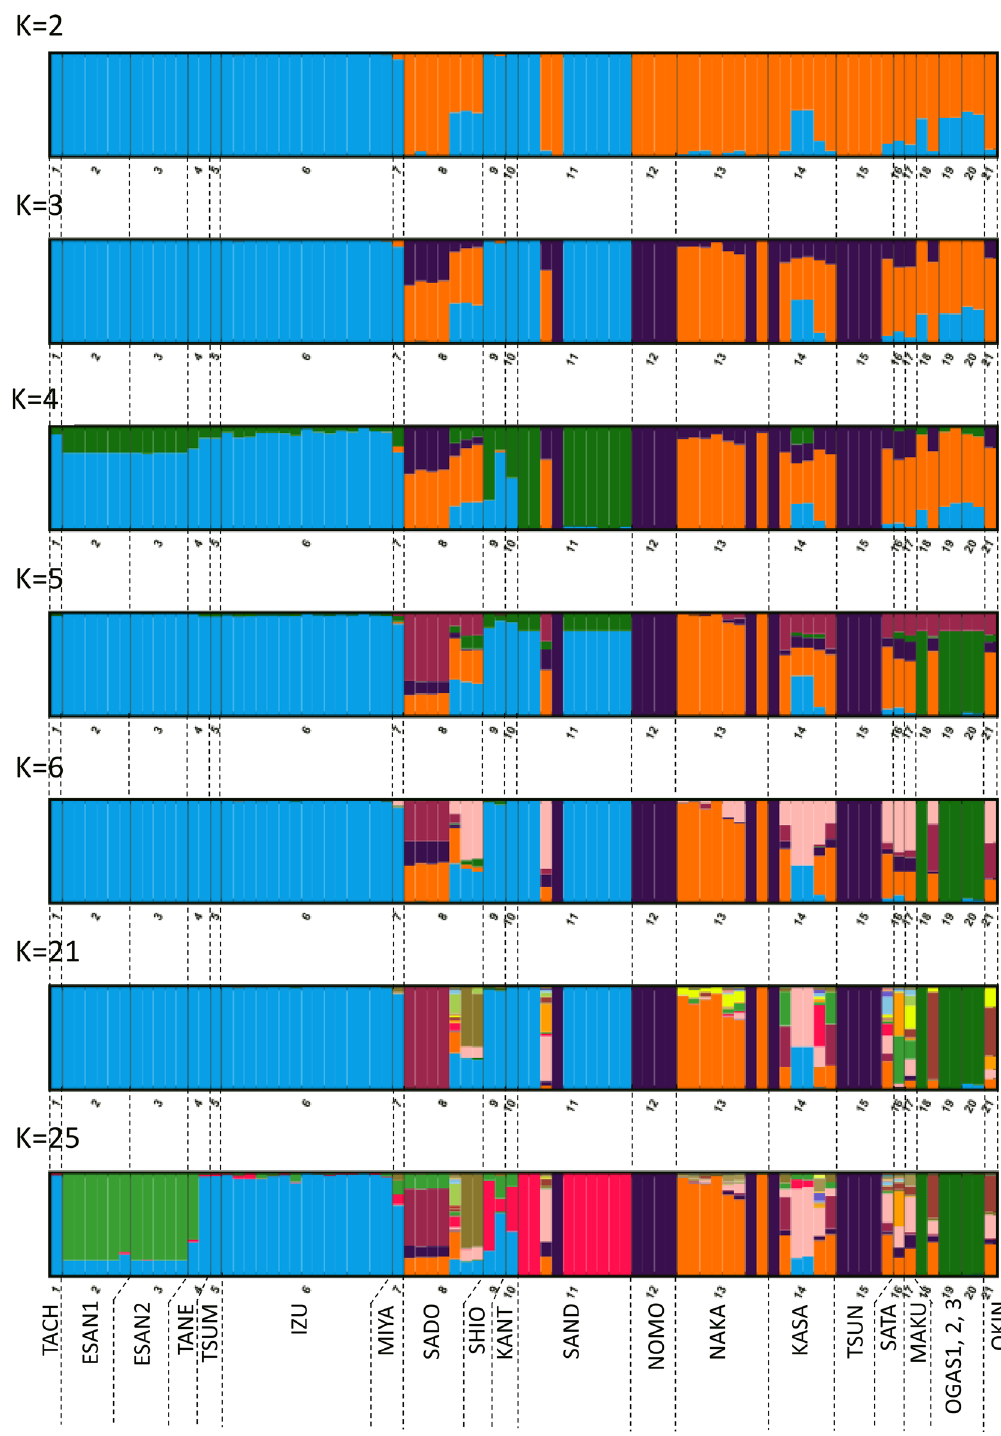
Figure 6. The STRU CTU RE analysis of C. falcatum subsp. australe and subsp. littorale . The proportion of the membership coefficient of 83 individuals in the 20 populations for each of the inferred clusters for K = 2, 3, 4, 5, 6, 21 and 25 defined using Bayesian clustering in STRU CTU